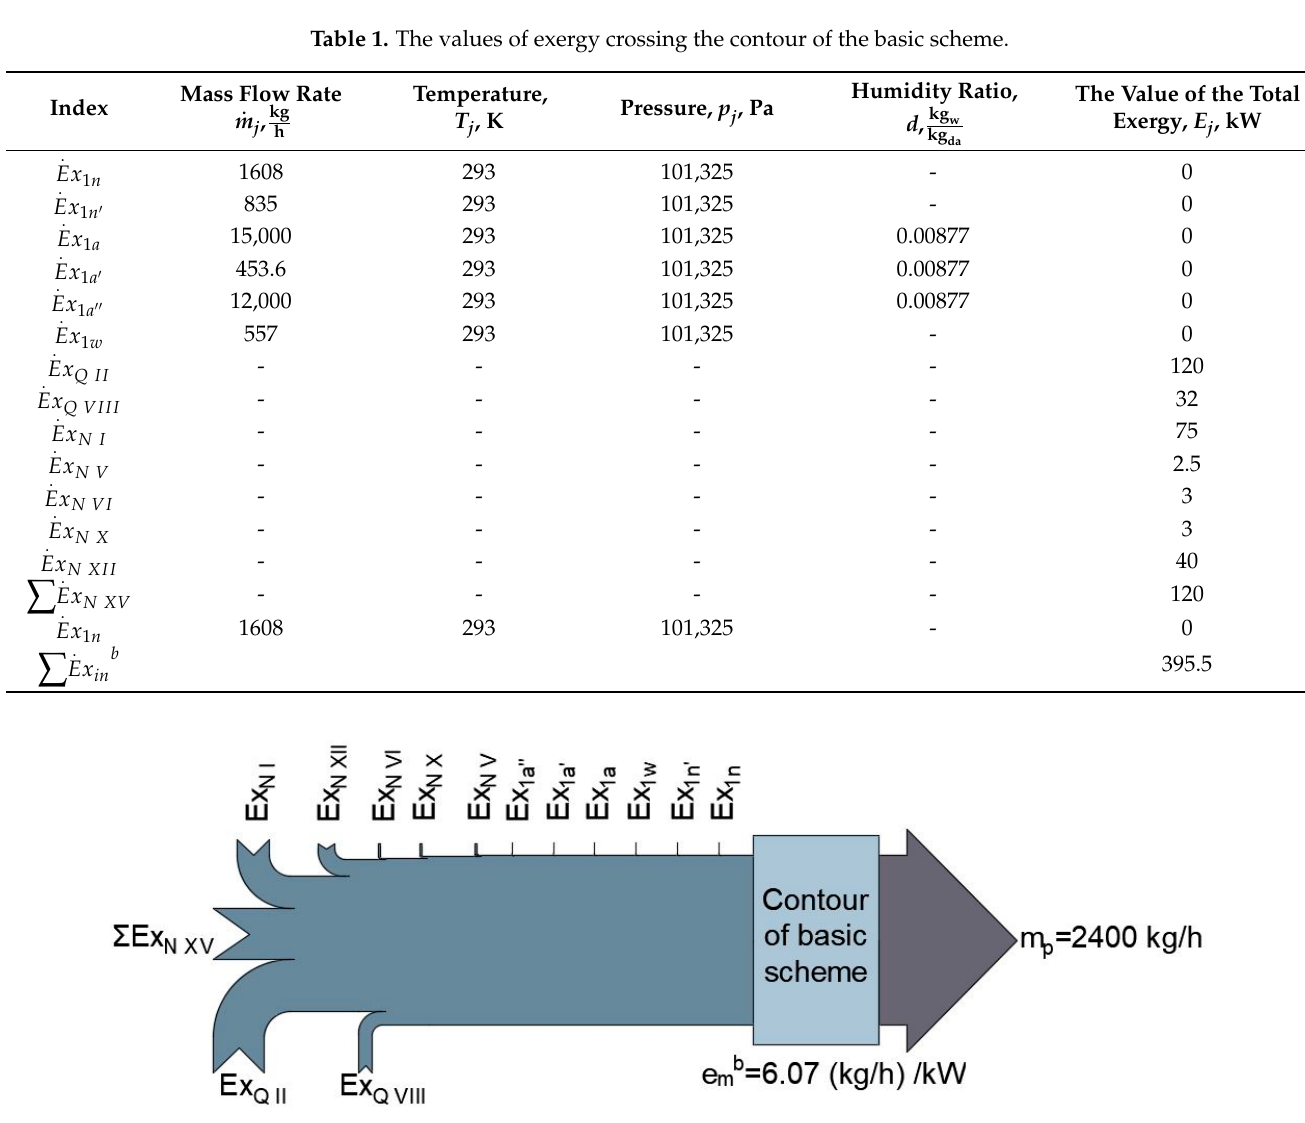
Figure 3. Sankey diagram for basic scheme.